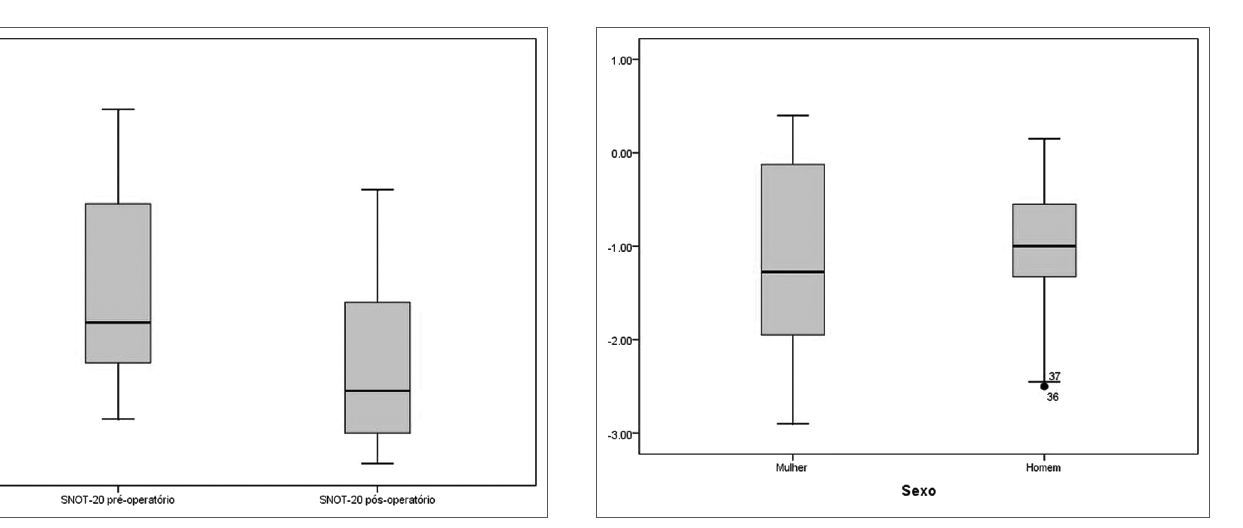
Figura 3. Diferença da pontuação total pré-operatória e pós-operatória entre os sexos no questionário SNOT-20 ( p =0,484).